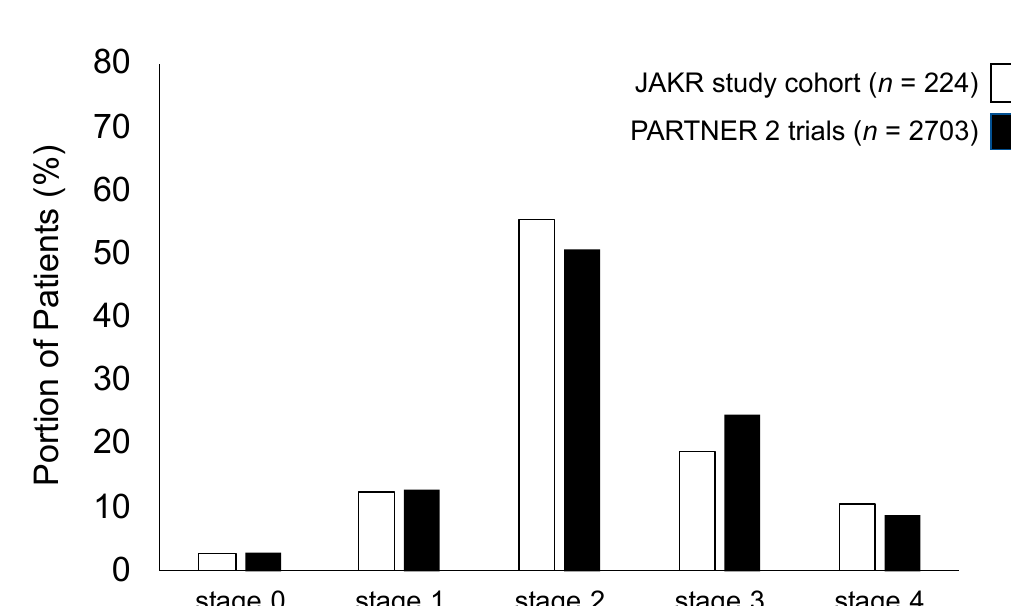
Figure 1. Comparison of extra-valvular cardiac damage staging according to the 2017 staging classification in the Jenaer Aortenklappenregister (JAKR) study cohort presented here ( n = 224, light grey) compared to the PARTNER 2 trials cohort ( n = 2703, dark grey) showing high levels of consistency.